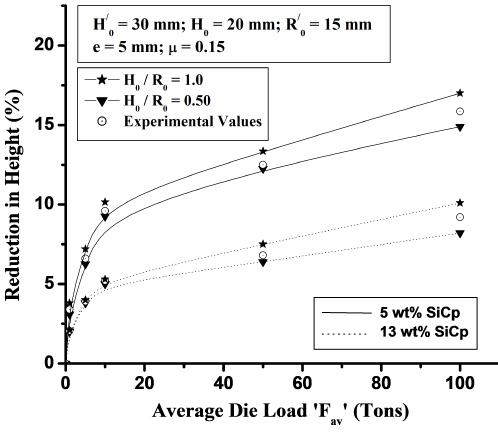
Fig. 7. Variation of Preform height Reduction with Die Load.